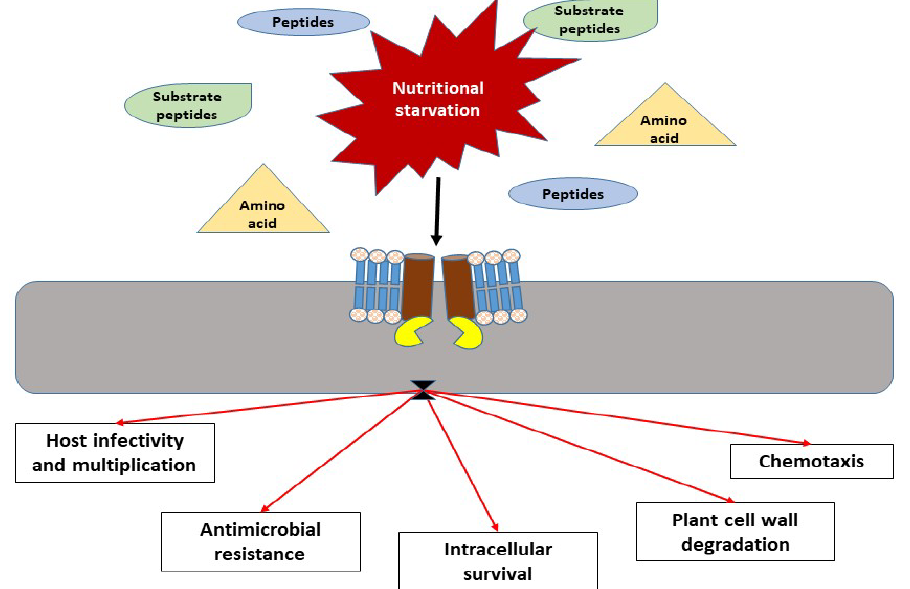
Figure 7. ABC peptide transporters use the nutritional starvation condition as the main inducer for their expression, which leads to major bacterial virulence such as plant cell wall degradation, chemotaxis, intracellular survival, antimicrobial resistance, infectivity, and multiplication in host plants (red arrows). The mechanisms involving component systems regulating the expression of peptide transporters are not included in this diagram.